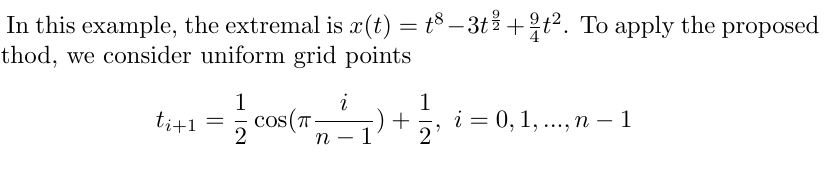
Figure 2. Absolute errors for n = 50 , 60 , 70 of Example